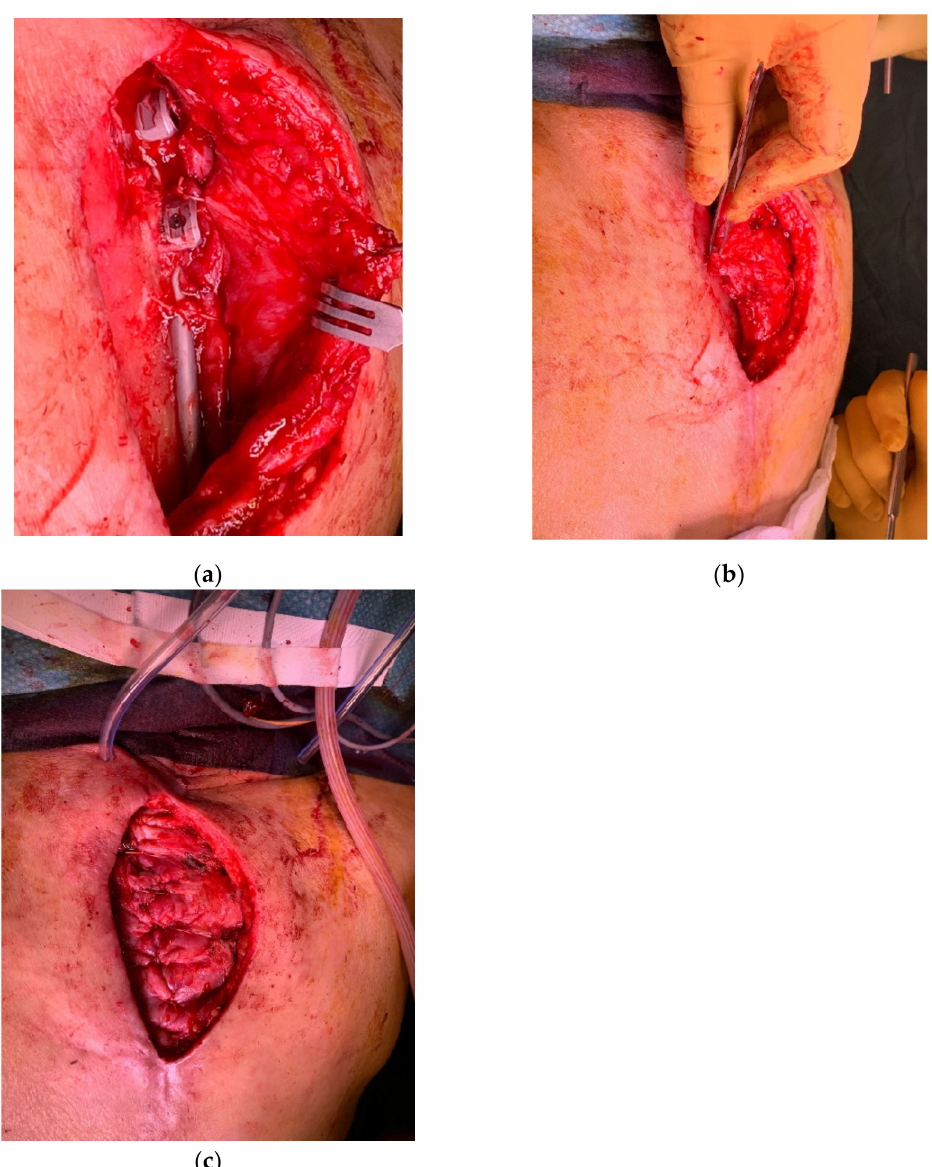
Figure 10. ( a ) Exposure of titanium bars in the dorsal spine; ( b ) the paravertebral muscles mobilized on both sides; and ( c ) tensionless suture and coverage of the